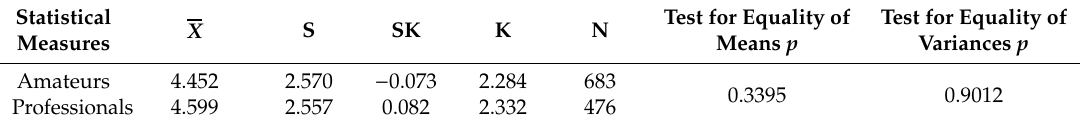
Table 10. Statistical characteristics of the lack of preferred sports and recreational activities at a sports and recreation facility, in the opinion of service